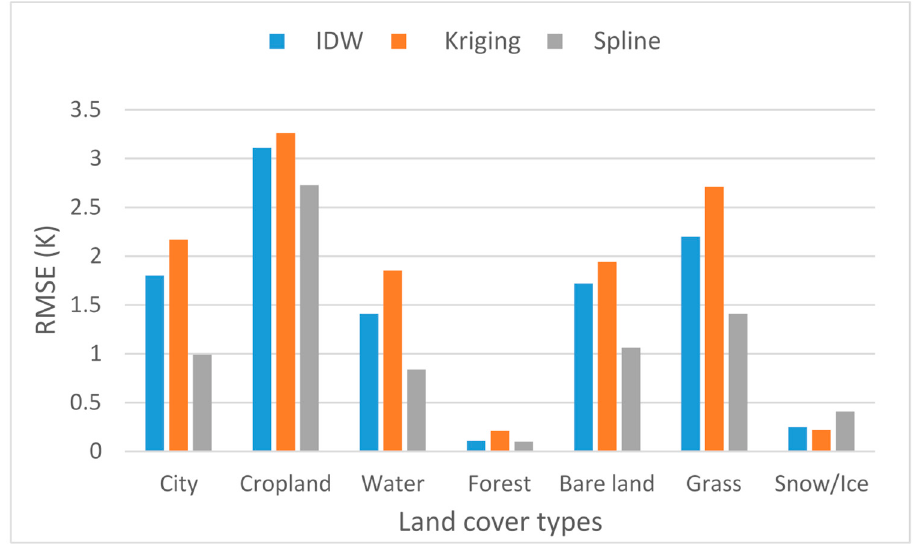
Figure 7. The RMSE of different spatial interpolation methods under different land use/covers.